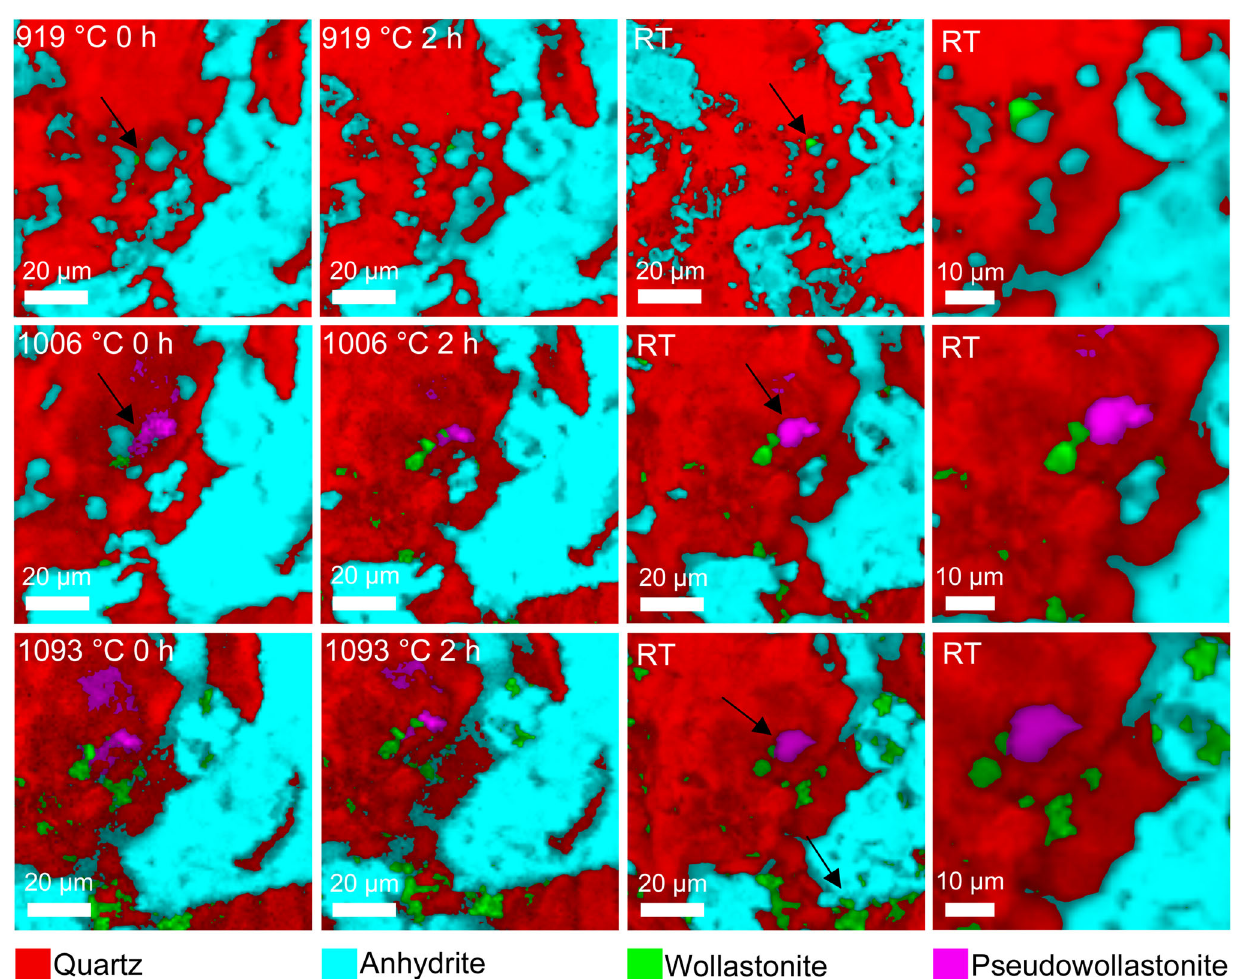
Fig. 6 Normalized false-color hyperspectral Raman images of the in situ/quench experiment